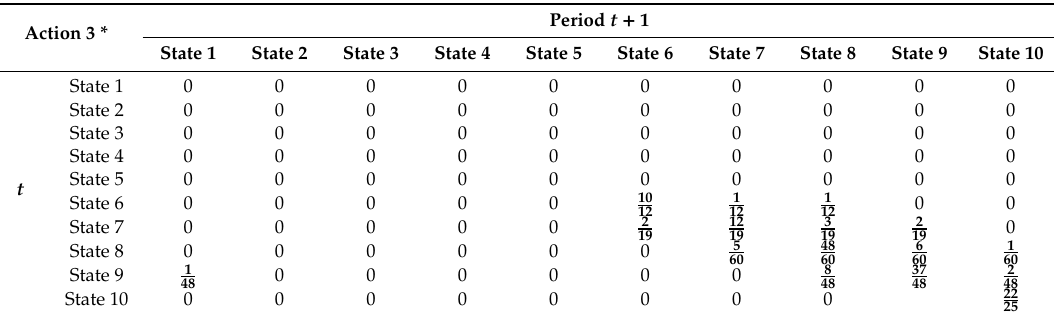
Figure A2. Inventory charts of action 2. Table A3. Transitions probability matrix of action 3.